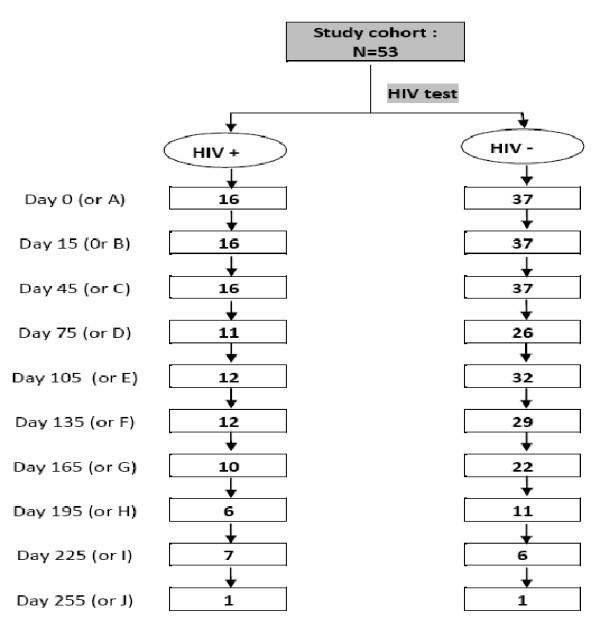
Sequential stools collection flow chart from the cohort study from Day 0 of follow up.